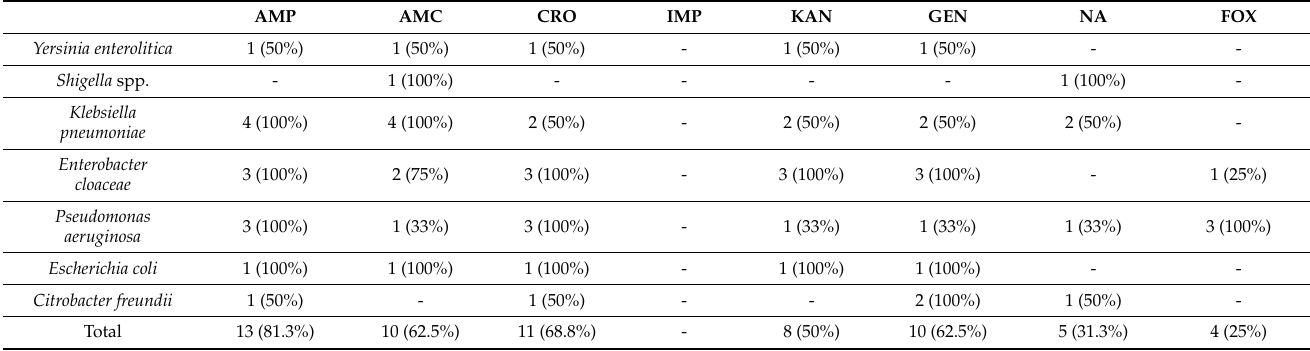
Table 4. Resistance to antibiotics in strains of Gram-negative bacilli.